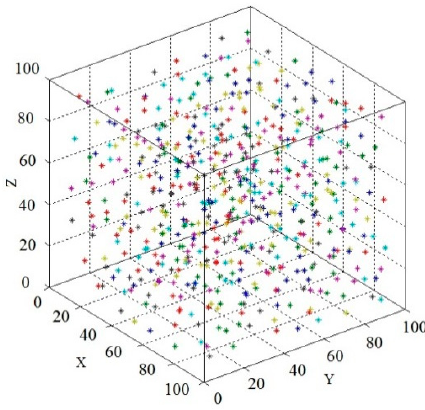
Figure 5. The aggregate coordinates scatter plot.